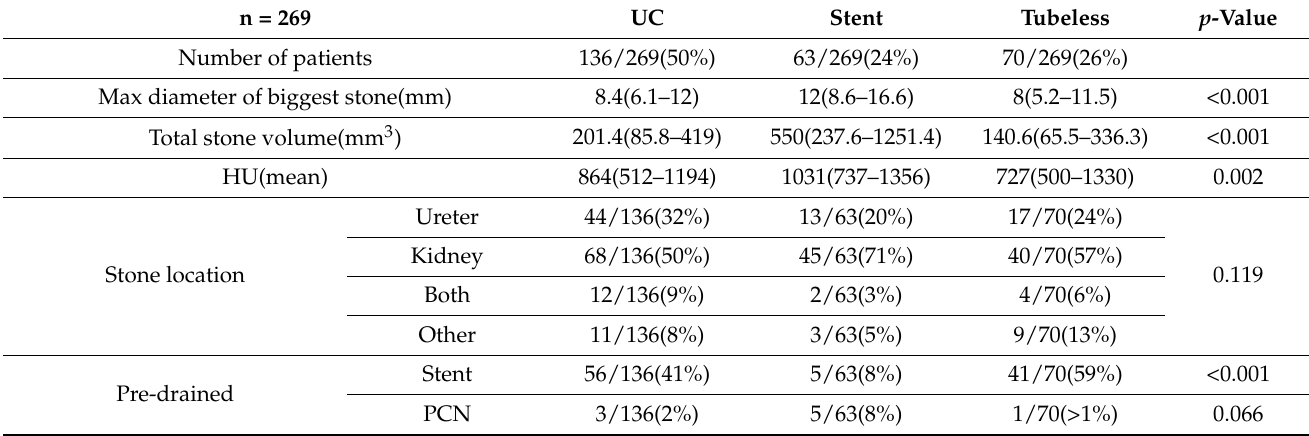
Table 1. Patients and stone